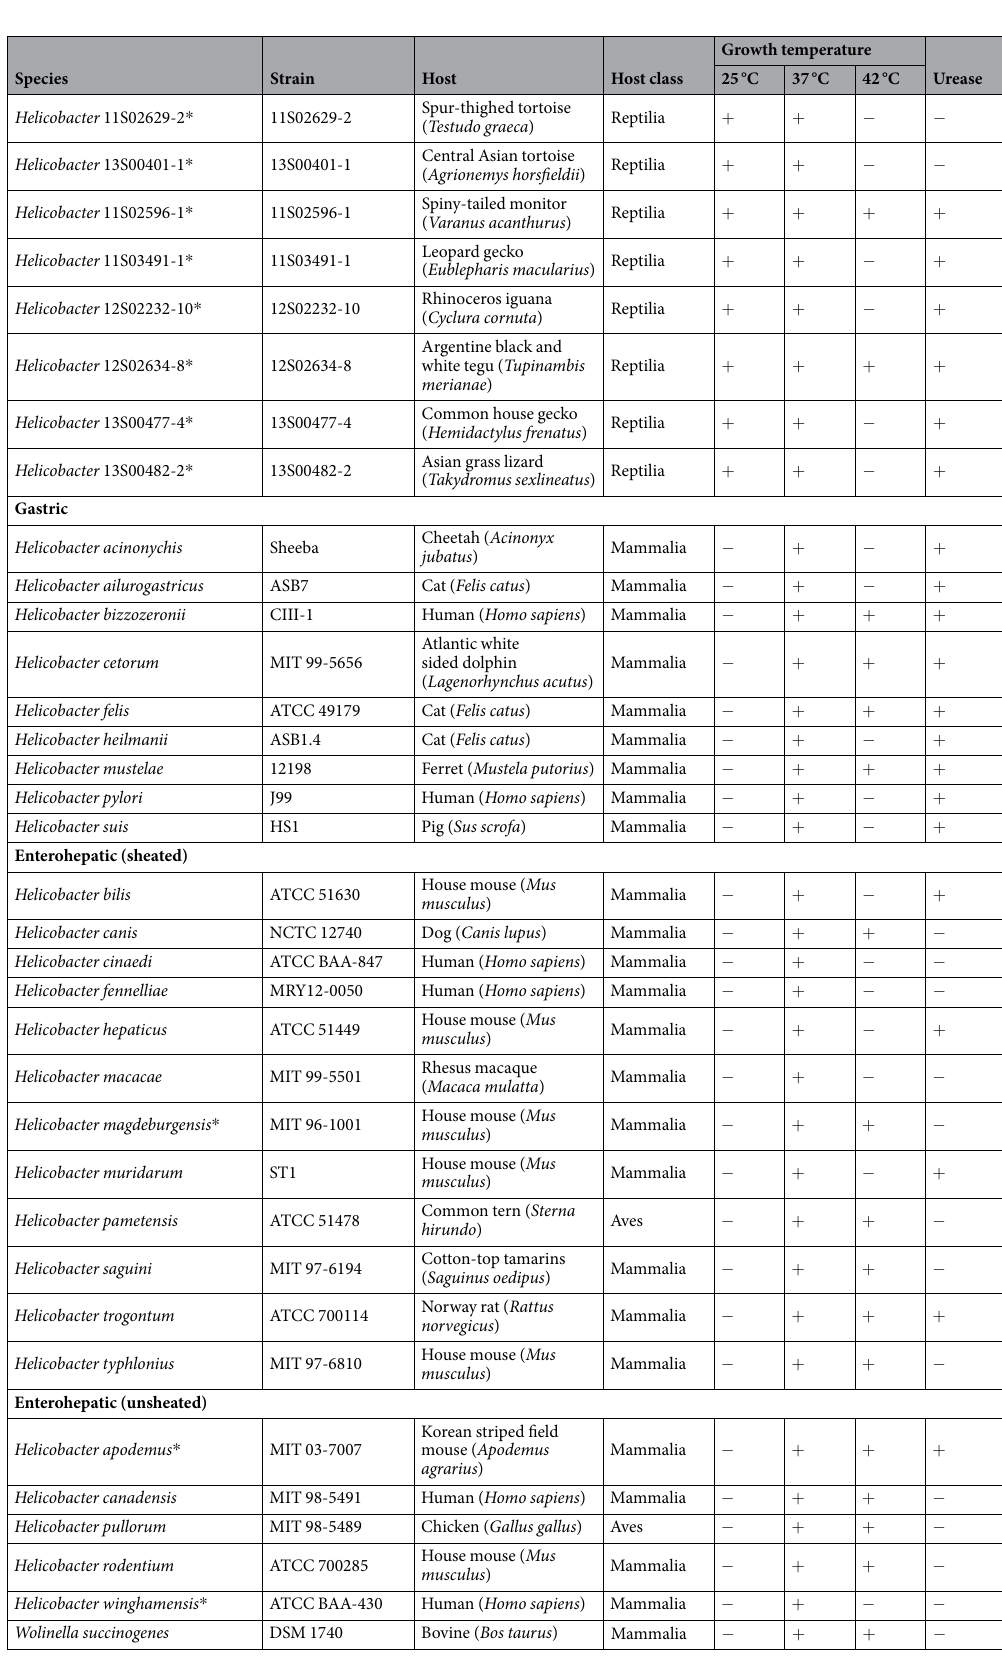
Table 1. Characteristics of the strains used in this study. Characteristics for reference strains are adapted from Schauer 1 , Lawson and Owen 4 , and Haesebrouck et al . 25 . * Candidate Helicobacter